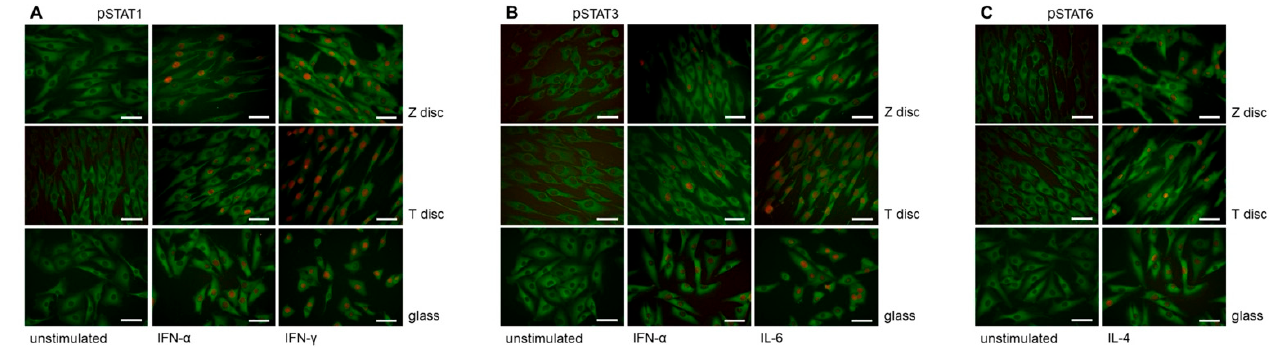
Figure 2. Immunofluorescence analysis of phospho-STAT proteins in MG-63 cells cultivated on discs (T and Z) or cover glasses for 72 h. ( A ) Phospho-STAT1 staining. The MG-63 cells were untreated (left panel) or treated with IFN- α (middle panel) or IFN- γ (right panel). Untreated and IFN- α /IFN- γ -treated cells were stained with anti-phospho-STAT1 and anti-vinculin antibodies. When the MG-63 cells were stimulated with IFN- α or IFN- γ , an intense nuclear immunostaining of phos- pho-STAT1 was observed (middle and right panels). The cytoplasm vinculin staining is shown in green. ( B ) Phospho-STAT3 staining. The MG-63 cells were untreated (left panel) or treated with IFN- α (middle panel) or IL-6 (right panel). All cells were incubated with anti-phospho-STAT3 antibodies (red) and anti-vinculin (green). In MG-63 cells stimulated with IFN- α or IL-6 an intense nuclear immunostaining of phospho-STAT3 was observed (right panel). ( C ) Phospho-STAT6 staining. The MG-63 cells were left untreated or treated with IL-4 (right panel). The cells were incubated with anti-phospho-STAT6 (red) and anti-vinculin (green) antibodies. In MG-63 cells stimulated with IL- 4, an intense nuclear immunostaining of phospho-STAT6 was observed (right panel). In all images magnification 40×, scale bar—50 nm. 3.3. Flow Cytometry Analysis of STAT Proteins In the next set of experiments, the expression of activated STAT proteins was ana- lyzed by flow cytometry. The MG-63 cells were incubated on T and Z discs, or on plastic ware without discs, for 72 h. The cells were then stimulated for 20 min with an appropriate cytokine and analyzed for the expression of phospho-STAT1, phospho-STAT3 and phos- pho-STAT6 proteins. The expression of phosphorylated STAT proteins in MG-63 cells after stimulation with 10 ng/mL of IFN- α , or IFN- γ , as well as with IL-6 and IL-4, is shown in Figure 3.